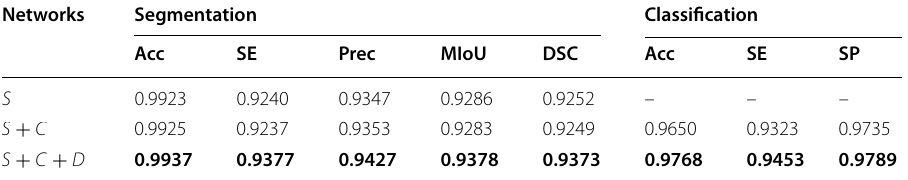
Table 6 Ablation study of each module in the whole framework, the highlighted values represent the best